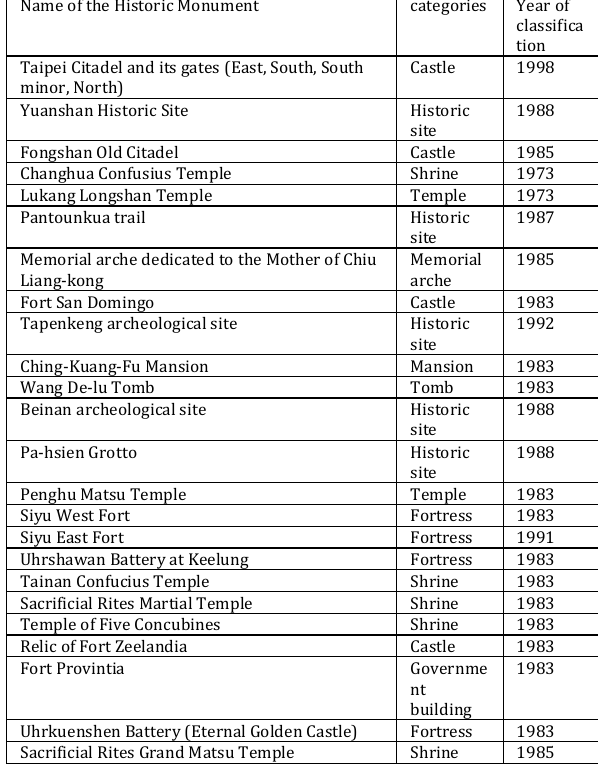
Table 1. List of First Grade Historic Monuments